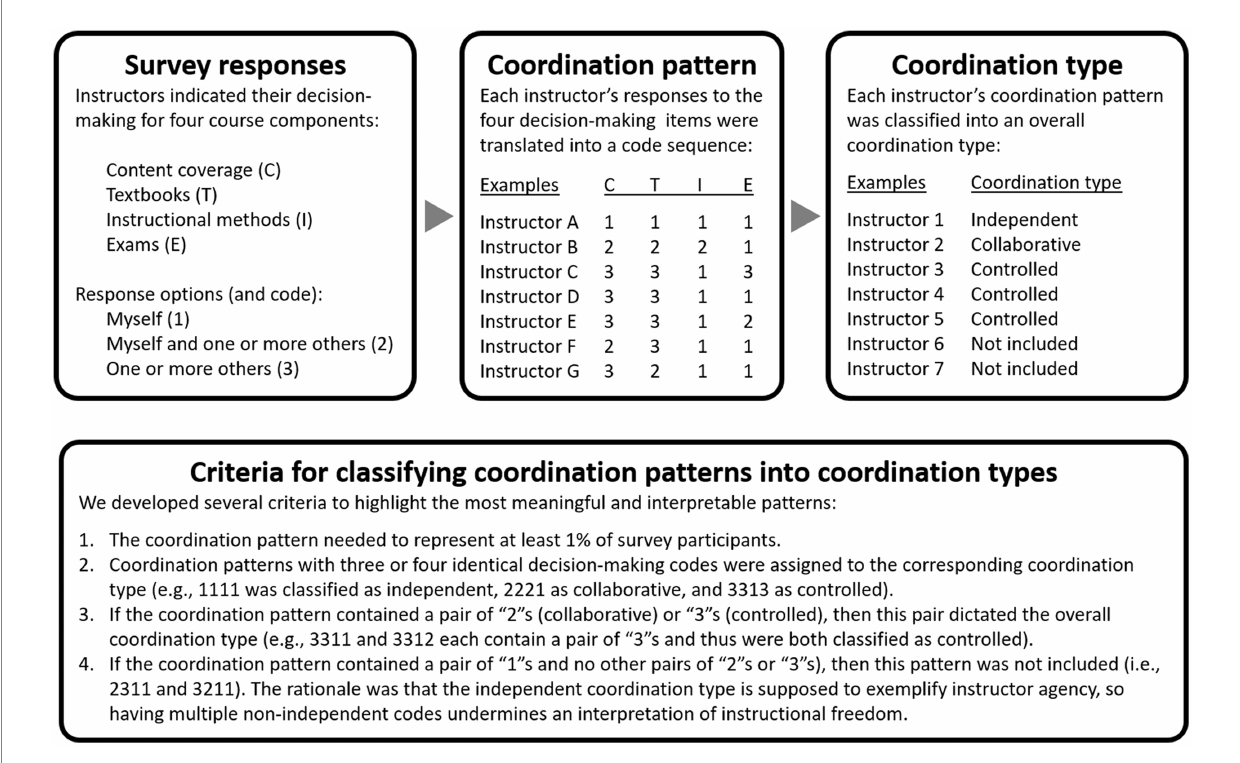
FIGURE 1 Overview of how survey responses were processed and